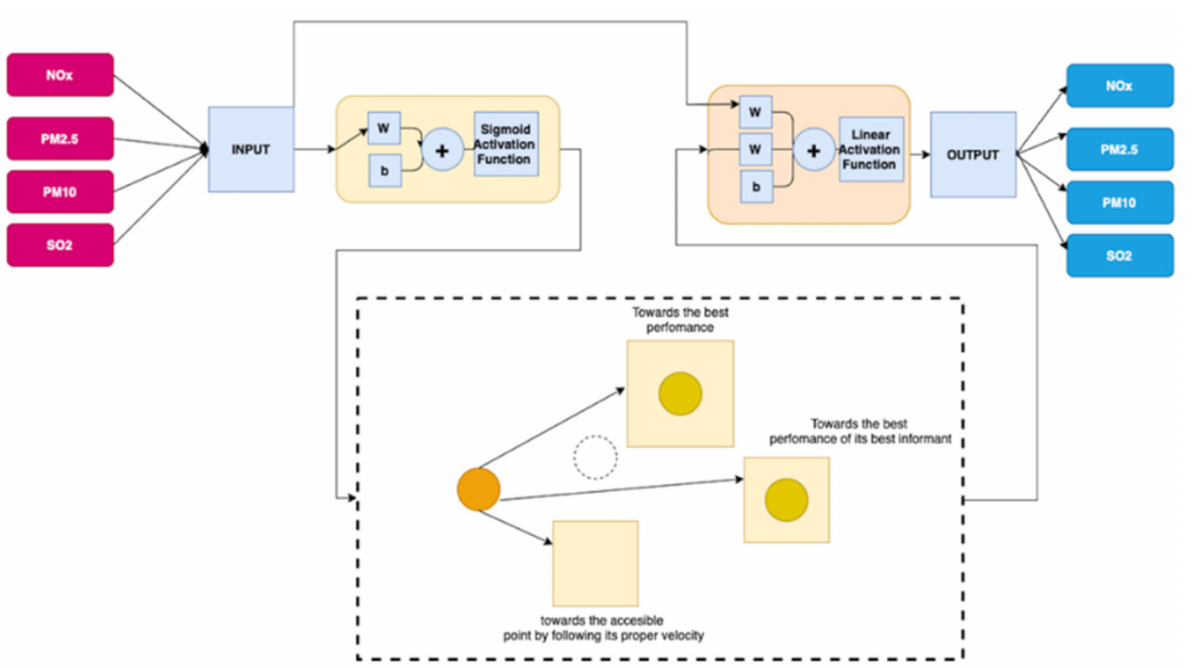
Figure 2. Space-time cascade neural network with particle swarm